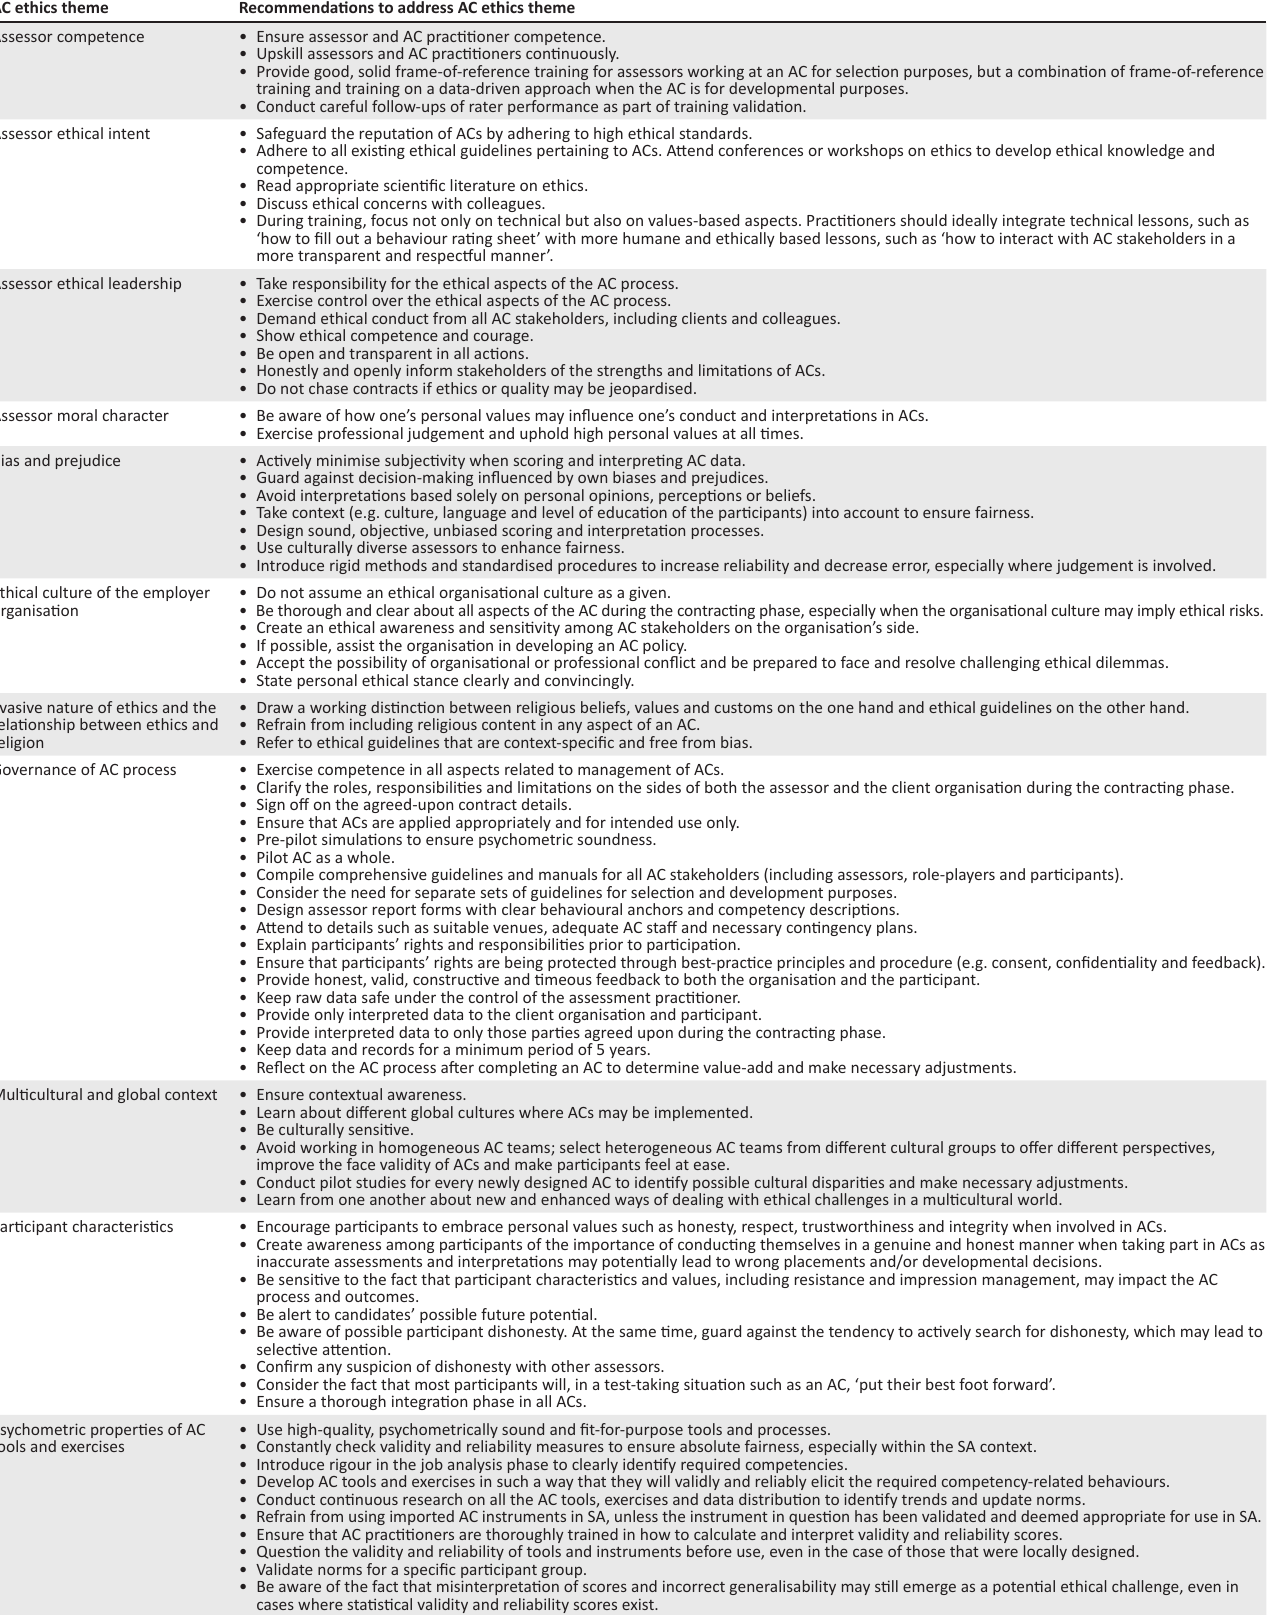
TABLE 1-A3: Recommendations to address ethical challenges in ACs in South Africa (listed in alphabetical order according to an overarching